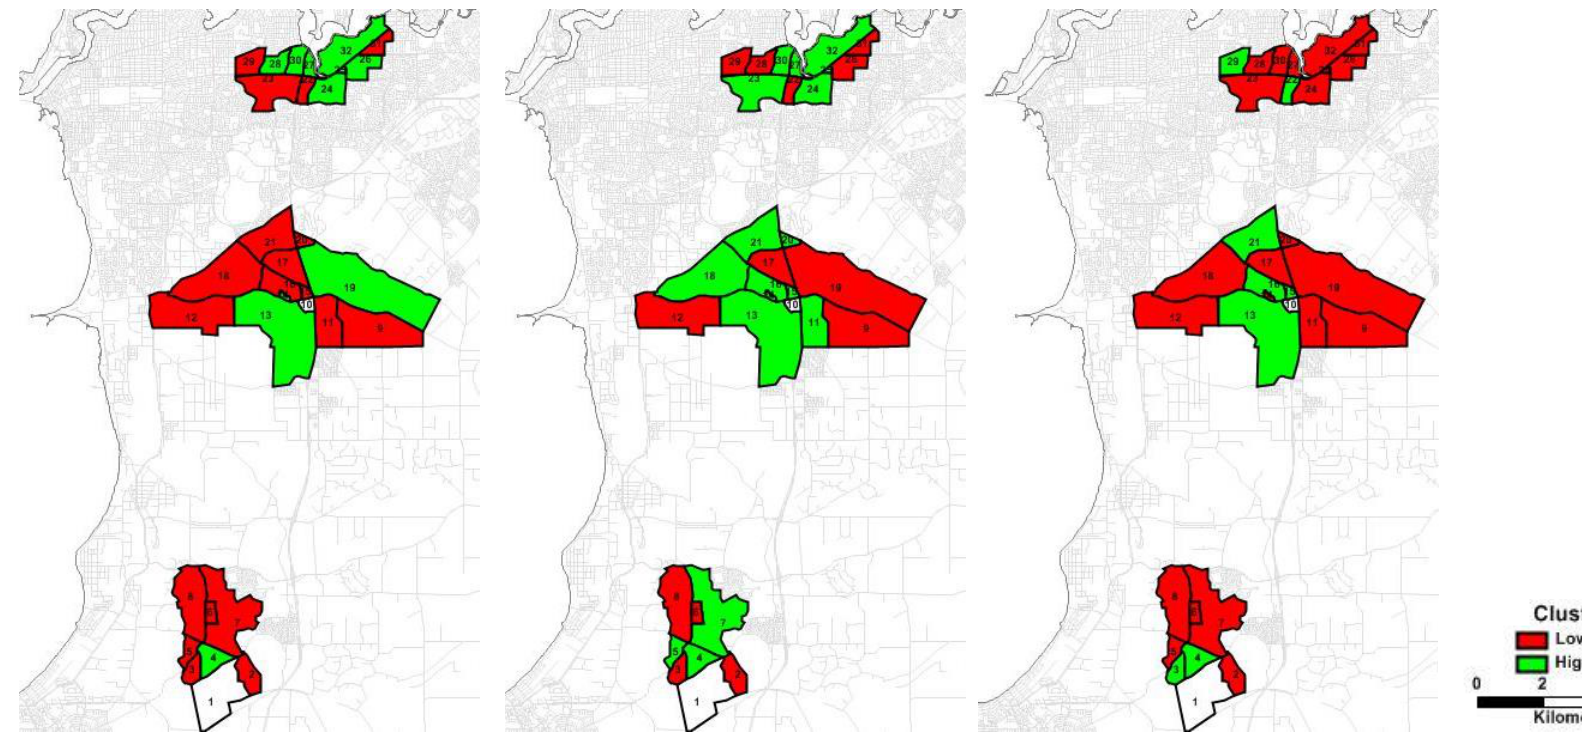
Figure 4. Clusters of high and low access for walking, cycling and PT